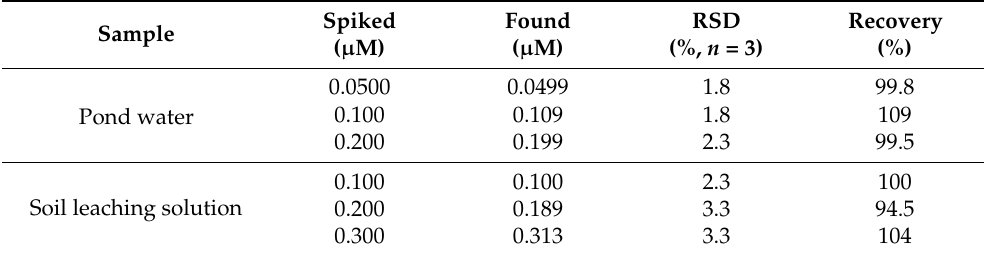
Figure S2.2: Optimization of growth time of VMSF; Figure S2.3: Optimization of pH of supporting elec- trolyte. Figure S2.4: Optimization of concentration of supporting electrolyte; Figure S2.5: Optimization of preconcentration time. Figure S3.1: Anti-interference ability of VMSF/3DG-CNT/GCE; Figure